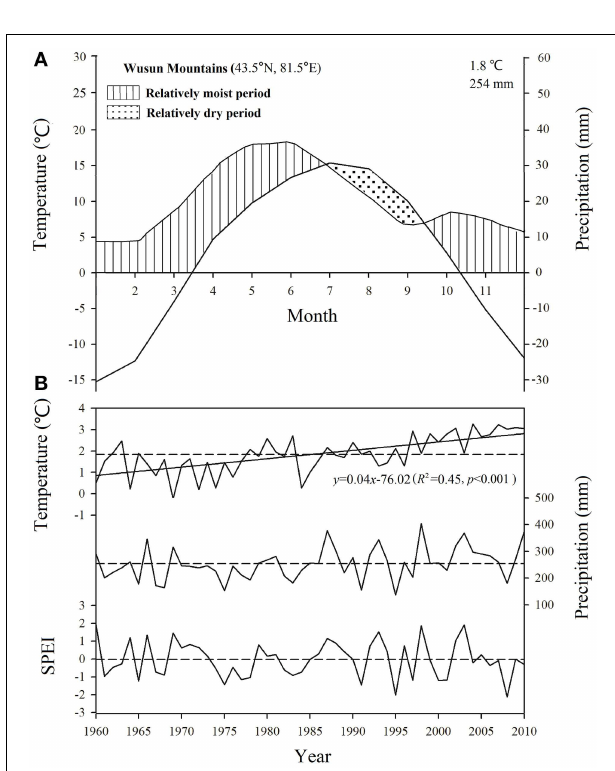
FIGURE 2 | (A) Climate diagram based on data during 1960–2010 from the CRU TS3.22 dataset for the nearest point in the grid in the Wusun Mountains. (B) Trends in the mean annual temperature, total annual precipitation, and standardized precipitation evapotranspiration index (SPEI) in August based on a 5-month time scale for the study area from 1960 to 2010. Horizontal dashed lines represent the mean value for this